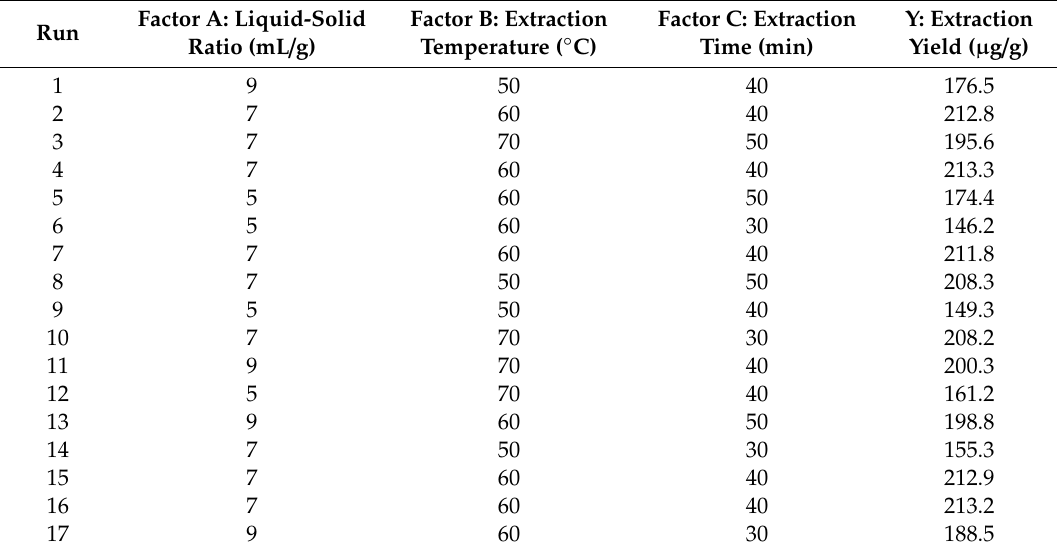
Table 2. Experimental results for the three-factor / three-level box-Behnken design (BBD).